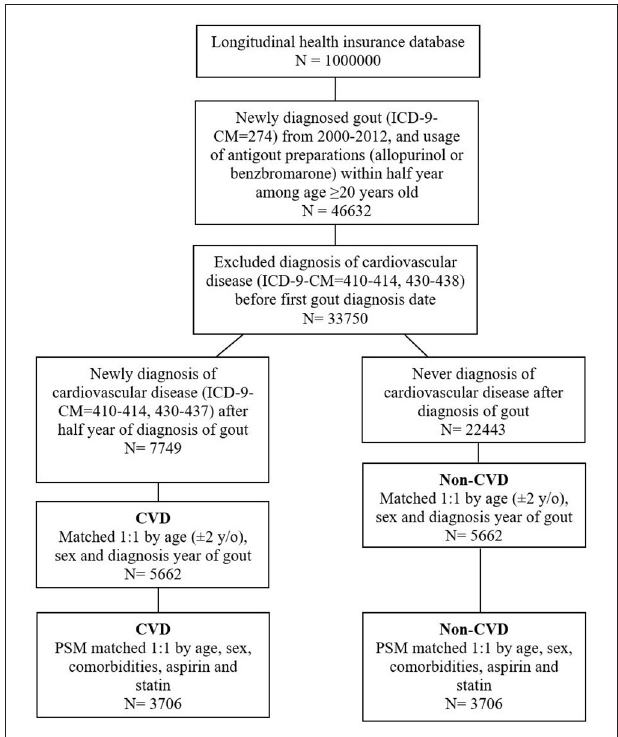
FIGURE 1 | The study population selection